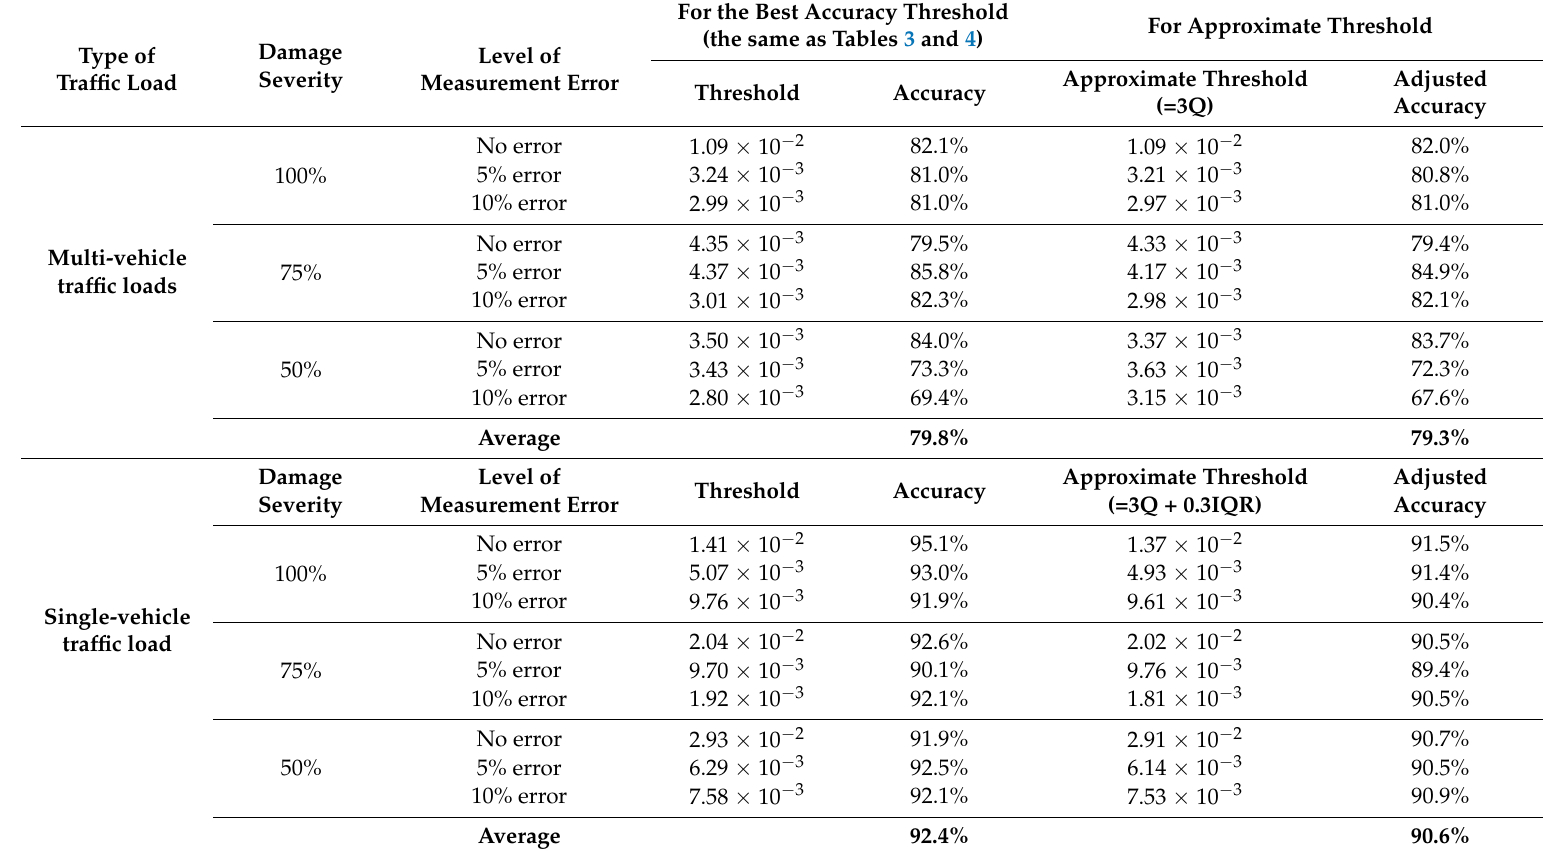
Table 5. Comparison between the best accuracy threshold and approximate